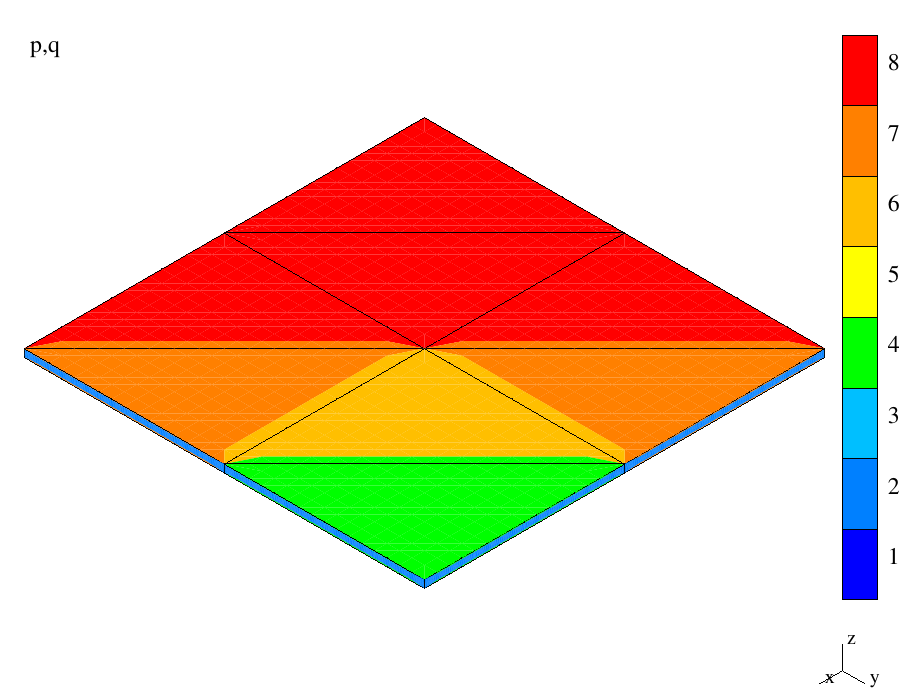
Figure 13. A quarter of a bending-dominated plate—after optimization and hp -adaptation.